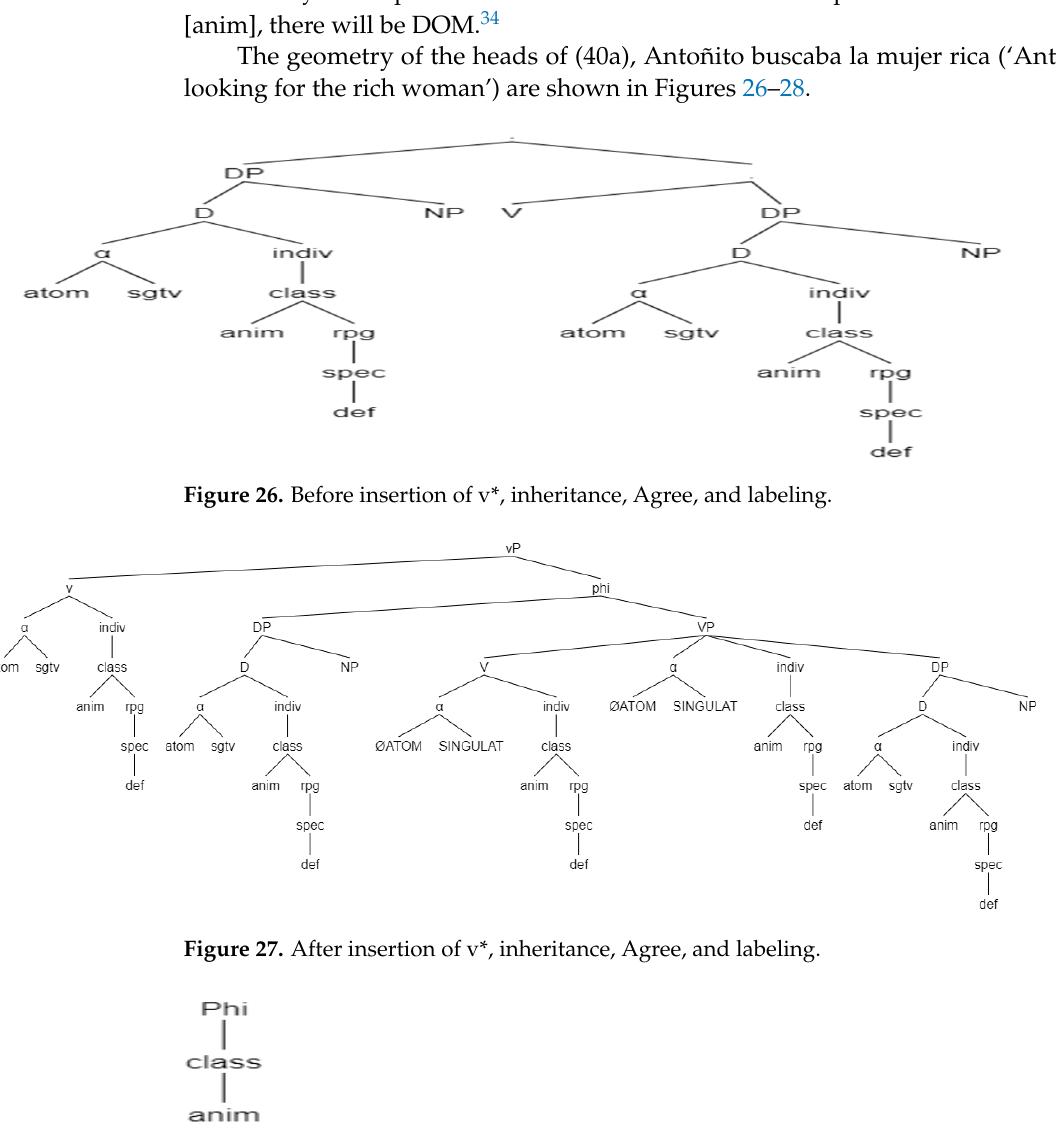
Figure 28. Geometry of the Phi label.